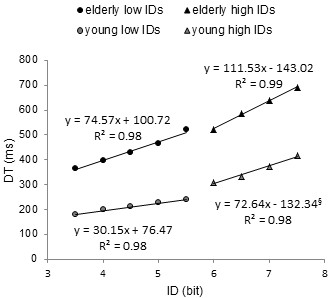
Decomposition of ID-DT relation as function of ID range and age group. Circles represents low IDs and triangles high IDs. Grey markers are used for young participants black markers for elderly. Mean data, linear fittings and their corresponding equations are presented. The “§” marked coefficient was not significant at 5%. It can be seen how DT is affected differently by ID at low and high difficulty levels and between age groups. Interestingly, the slope value for low IDs in older participants is found to be comparable to that for high IDs in younger participants.